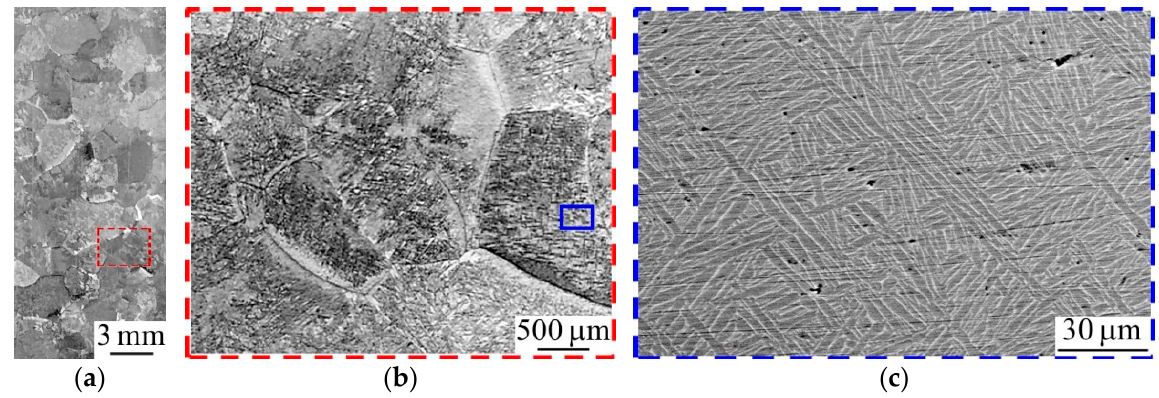
Figure 7. Optical ( a , b ) and SEM micrographs ( c ) of the microstructure of the EBAM Ti-6Al-4V samples produced with substrate cooling. Dashed red line box in ( a ) highlights the area that is enlarged in ( b ). Dashed blue line box in ( b ) highlights the area that is enlarged in ( c ). The microstructures were obtained from longitudinal direction at the central part (at a distance of 40 mm from the substrate) of the rectangular Ti-6Al-4V bar.